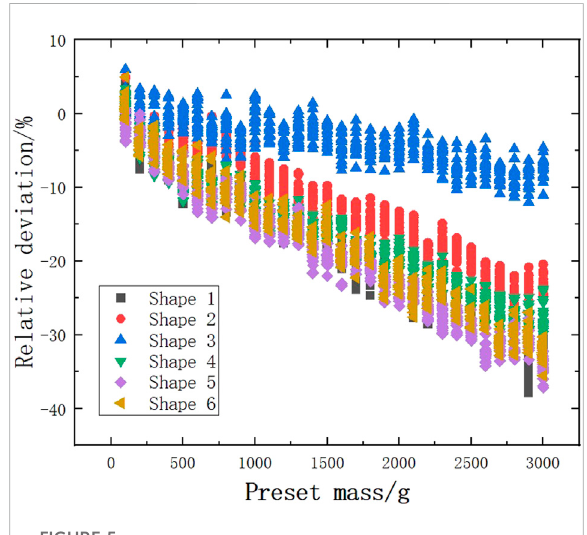
FIGURE 5 Mass simulated deviation of different shaped